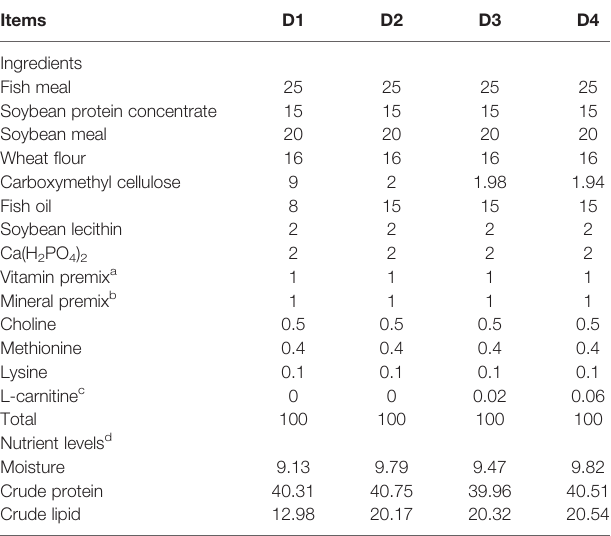
TABLE 1 | Composition and nutrient levels of the experimental diets (%DM basis).